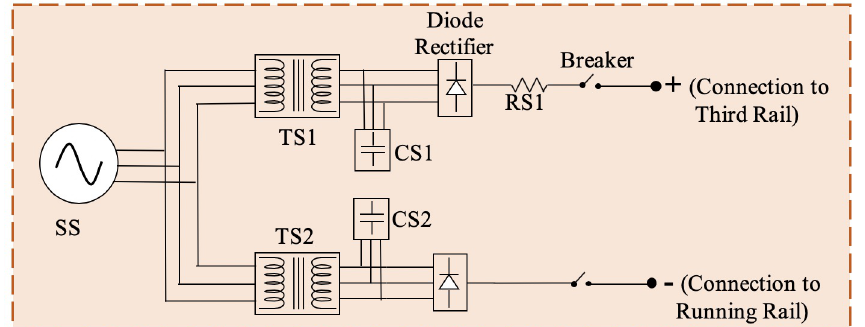
Figure 4. Simulation model of substation.